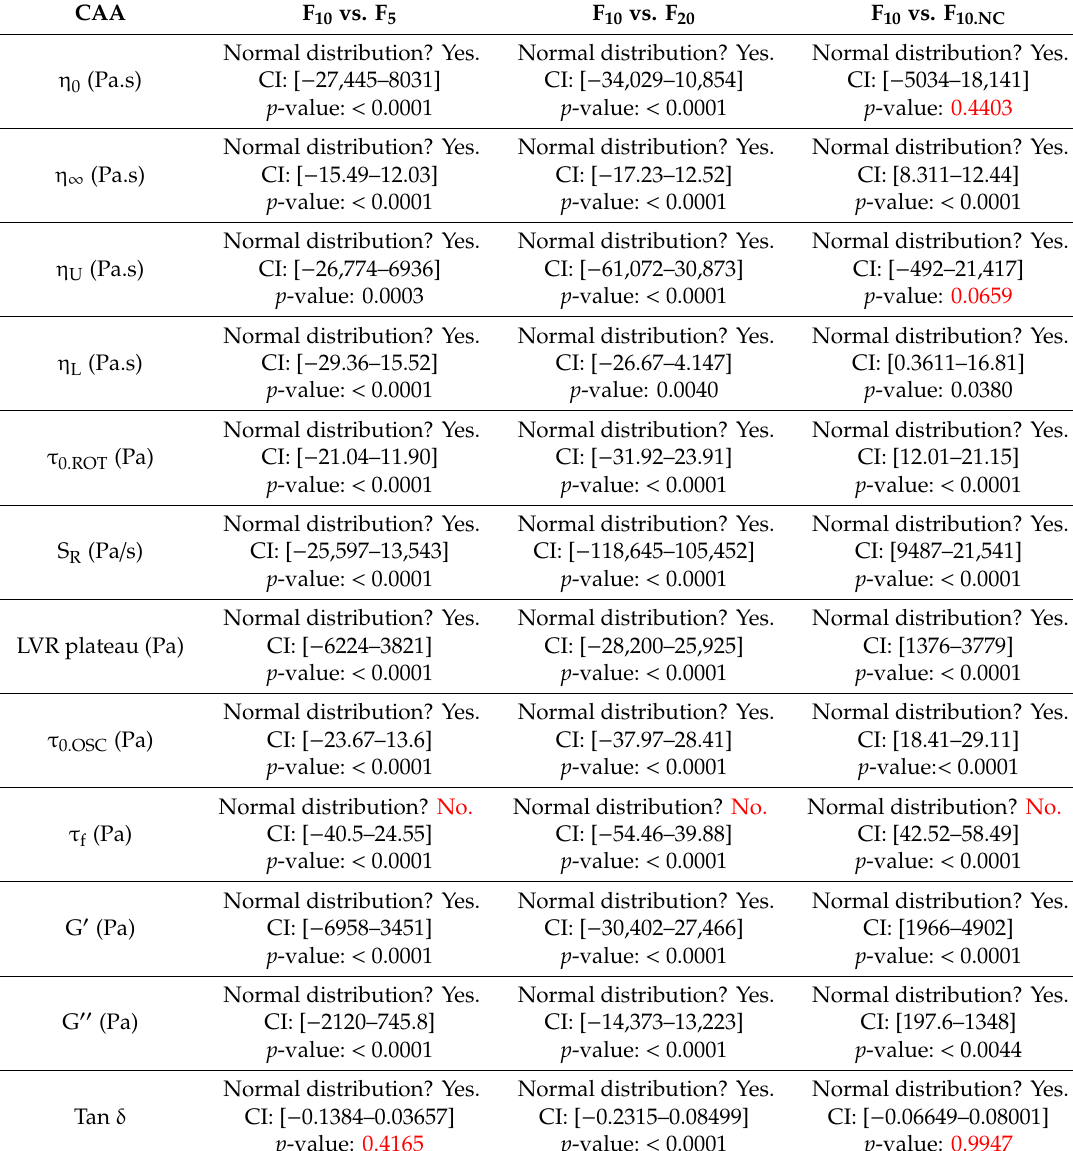
Table 5. Selectivity results. A one-way analysis of variance (ANOVA) with a Tukey multiple comparison test was performed. The di ff erences between the means were considered to be significant for values of p < 0.05. CAA F 10 vs. F